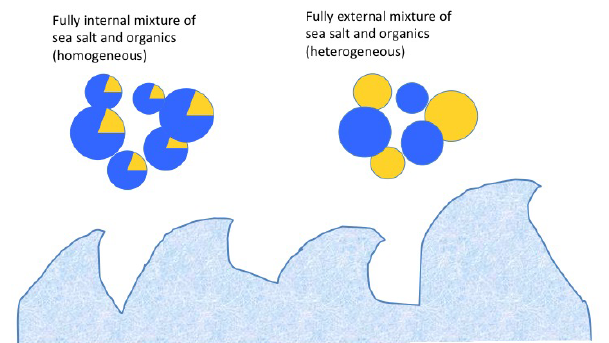
Figure 1. Illustration of internal versus external mixing states of sea spray aerosol upon emission. The emitted aerosol contains both sea salt (blue) and organic matter